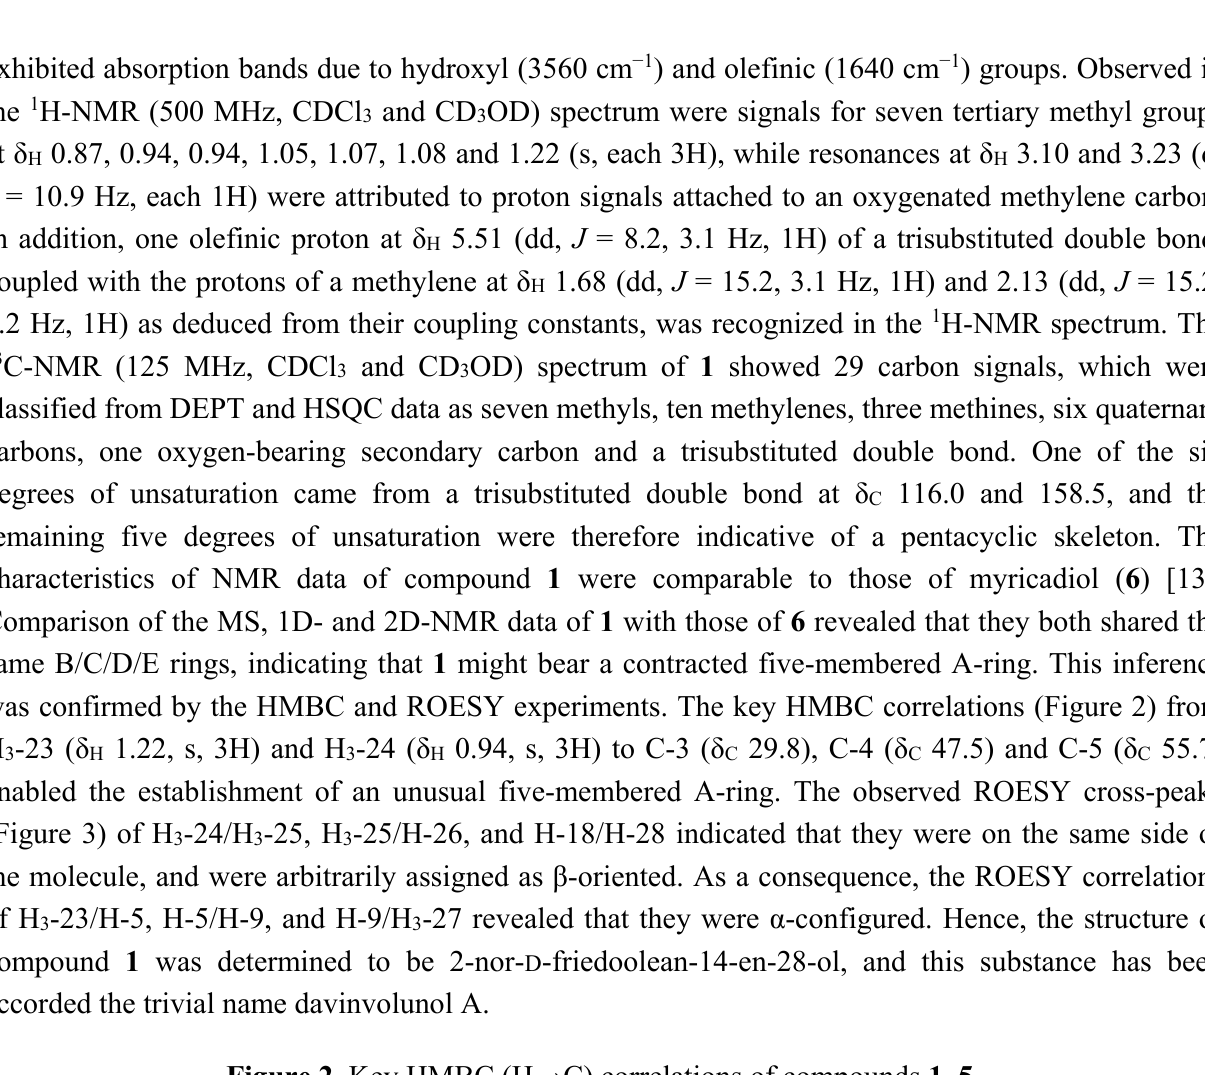
Figure 2. Key HMBC (H → C) correlations of compounds 1 – 5